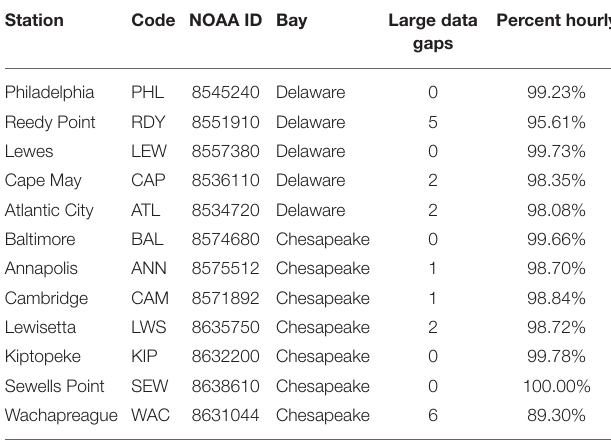
TABLE 1 | Tide gauges used in the current